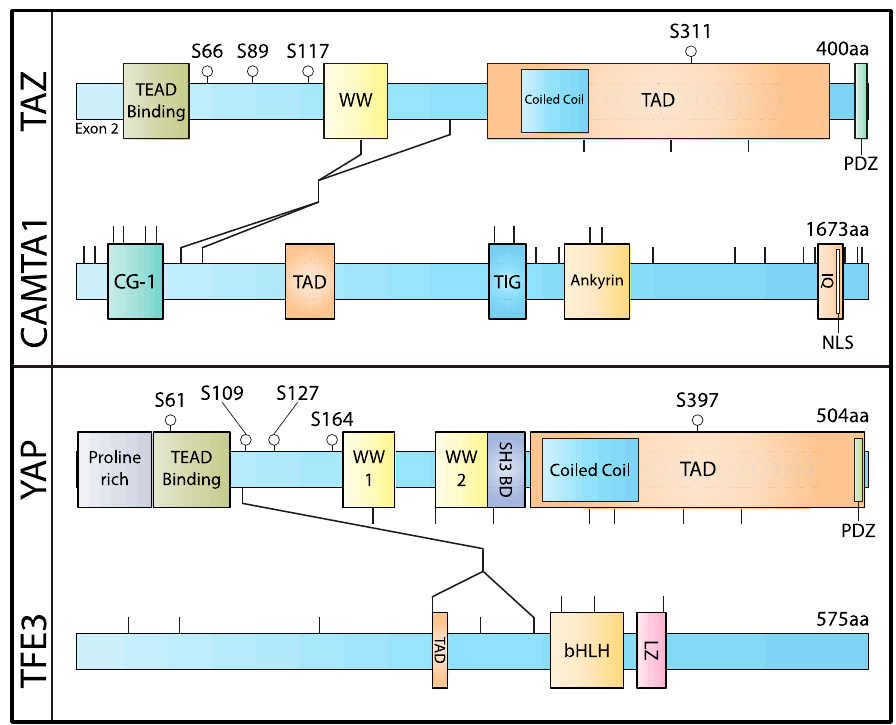
Figure 2. Schematic of the proteins present in TAZ–CAMTA1 and YAP–TFE3 fusions, with the most common breakpoints within the proteins. TAZ and YAP are labeled above with the LATS1/2 phosphorylation sites. The markers below display the amino acid contributions of each exon, and the lines between sequences denote common fusion sites: WW: WW domain; TAD: transactivation domain; PDZ: PDZ-binding motif; CG-1: CG-1 DNA-binding domain; TIG: transcription-factor immunoglobulin domain; Ankyrin: ankyrin repeats; IQ: IQ calmodulin-binding motifs; NLS: nuclear-localization signal; SH3 BD: SH3-binding domain; bHLH: basic helix–loop–helix domain; LZ: leucine-zipper domain.